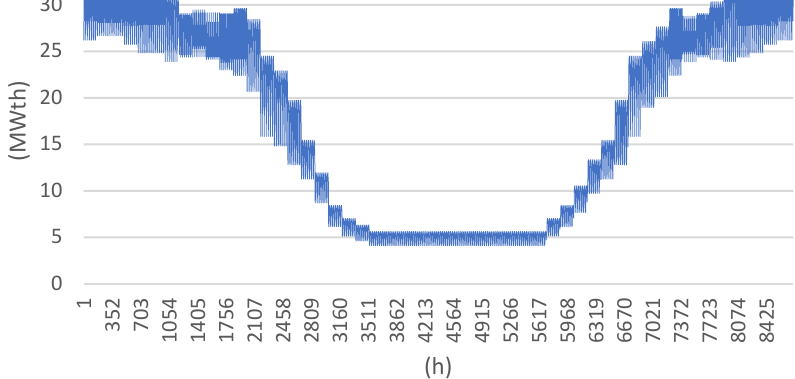
Figure 5. Heating energy demand.